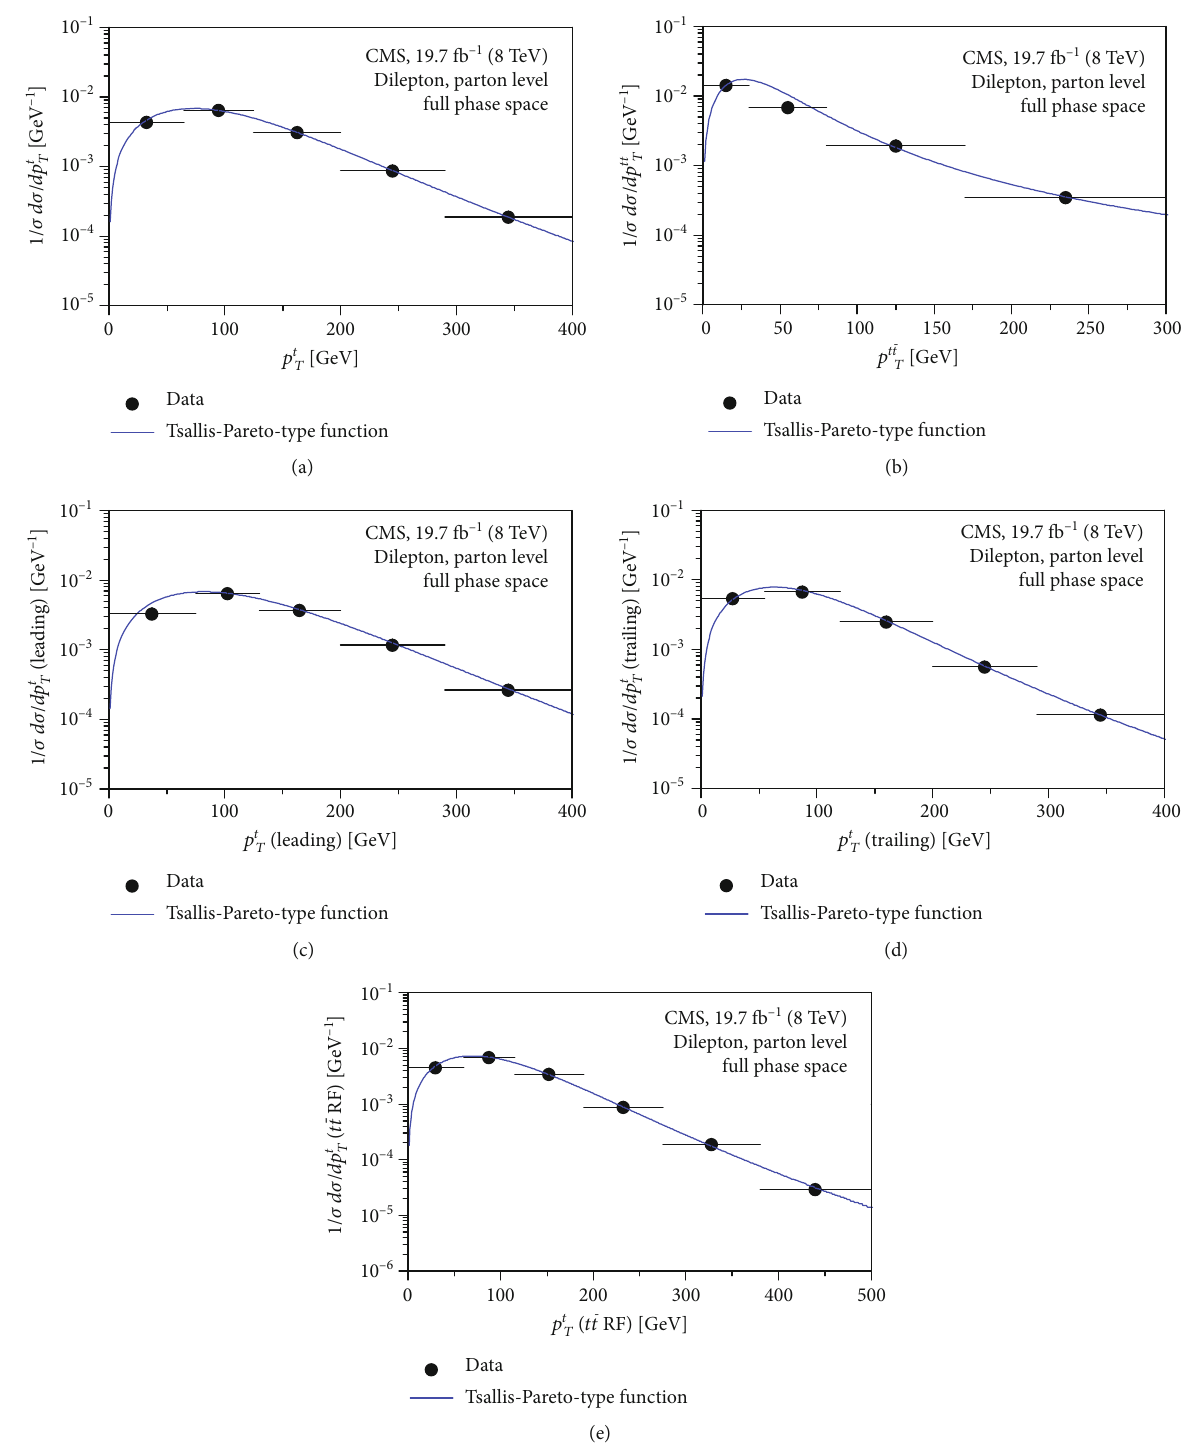
p t (cid:1) t p t p t T , (b) T , (c) T (leading), (d) T